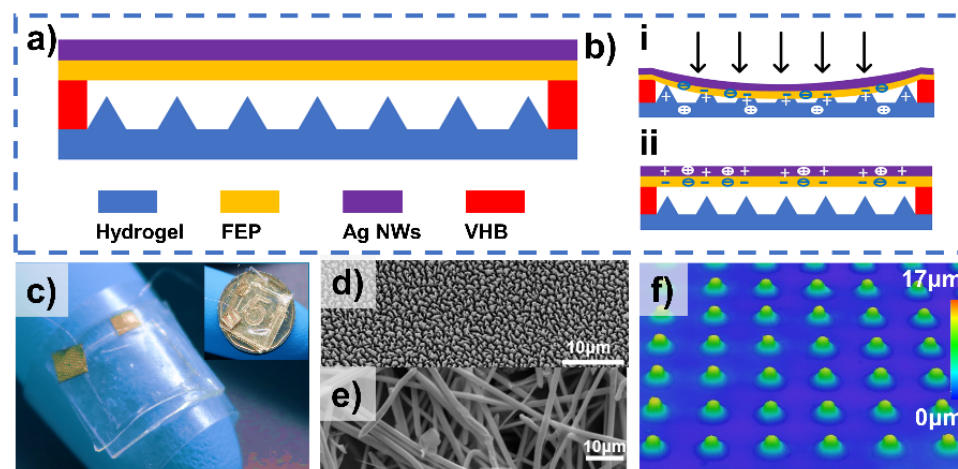
Figure 1. The basic structure of (electret/hydrogel ‐ based tactile sensor EHTS): ( a ) Structure design of the proposed EHTS; ( b ) Schematic diagram of the ETHS at the compressed state (i) and released state (ii); ( c ) Photograph of the fabricated device attached on the fingertip. The inset is the ETHS on a fifty ‐ cent coin; ( d , e ) Scanning electron microscopy (SEM) images of the nanostructured fluorinated ethylene propylene (FEP) film surface and the fabricated AgNWs electrode; ( f ) Confocal Laser Scanning Microscope (CLSM) image of the micro ‐ pyramidal structures on the hydrogel.